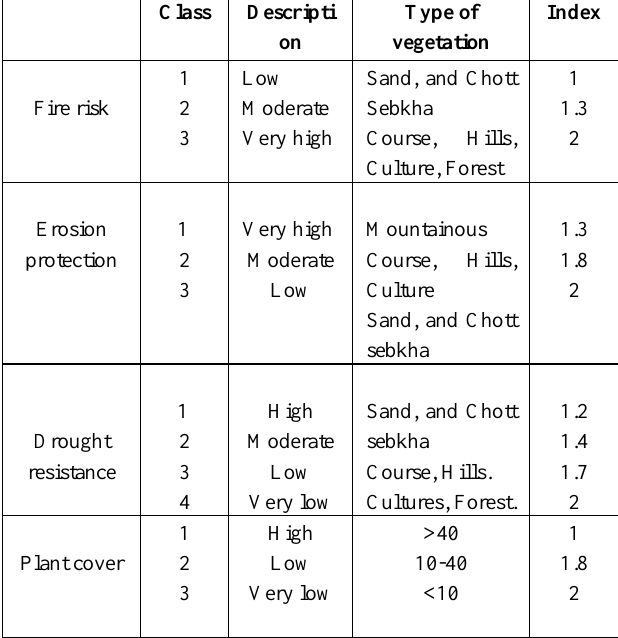
Table5. Relationship between type of vegetation and